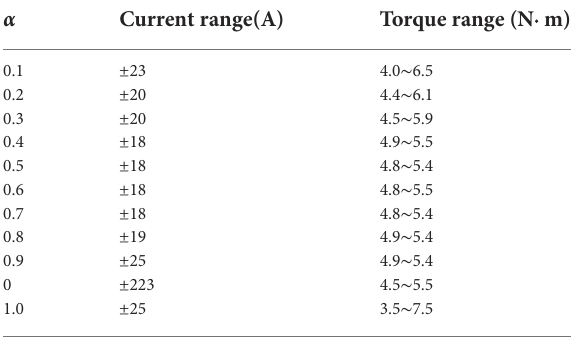
TABLE 2 Relationship between different adjustment factors and current range and torque